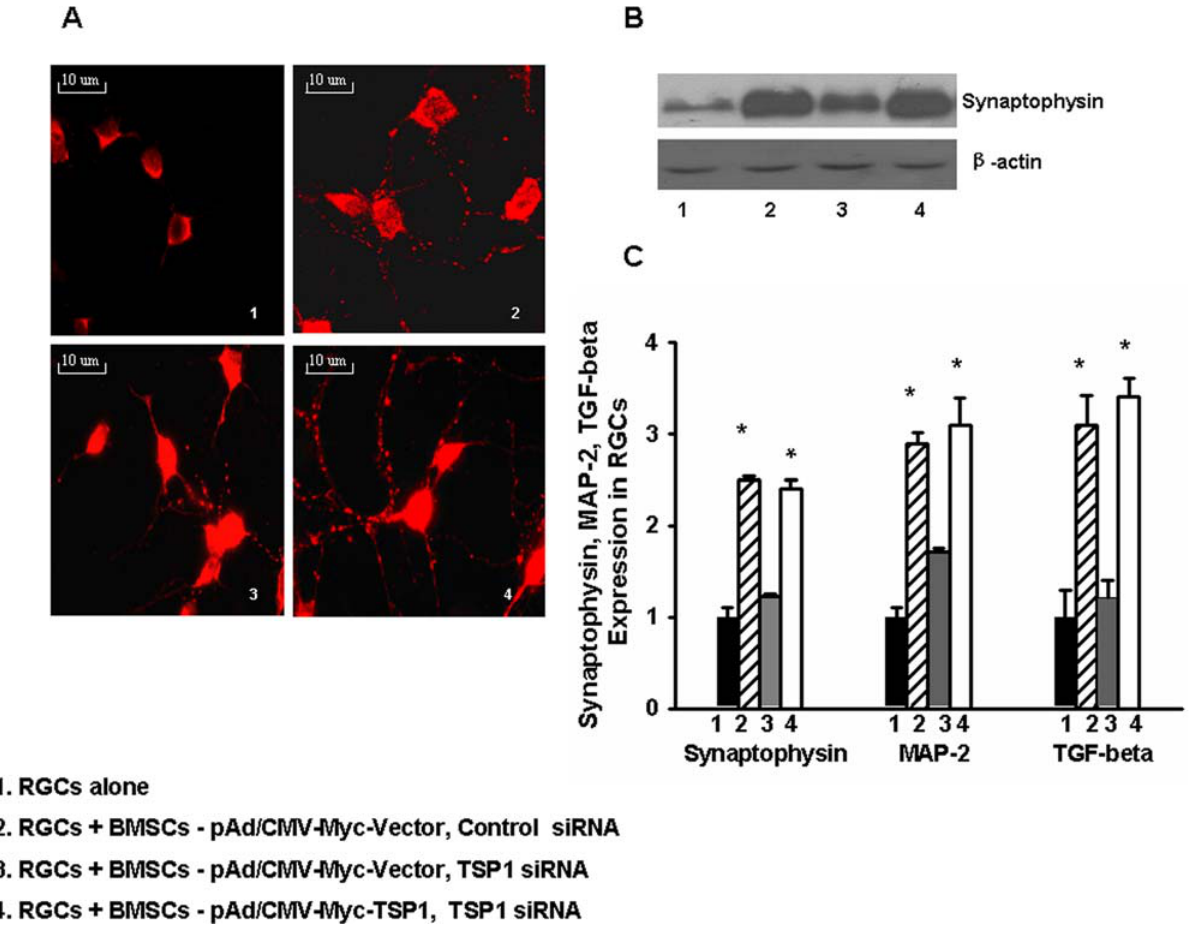
Figure 7. RGC synaptophysin, MAP-2 and TGF- b expression level were determined with and without BMSC ( + / 2 TSP-1 siRNA silencing) co-culturing. BMSCs were transfected with siRNA oligos and infected with a recombinant adenovirus (pAd/CMV-Myc-TSP-1) expressing TSP-1 before co-culturing as described above. A , After 3 days, immunohistochemical analysis of RGCs for synaptophysin (red dots) shows more synaptic puncta when co-culturing with BMSCs compared to RGCs alone (2 & 4), but fewer when TSP-1 was silenced by siRNA (3). B , Western blot shows synaptophysin in RGCs is up-regulated by TSP-1; (2), which was diminished by TSP-1 silencing (3) and restored by TSP-1-expressing adenoviral rescue (4). C , After 3 days, synaptophysin, MAP-2 and TGF- b expression were determined by real-time RT-PCR (p=0.019, p=0.020, p=0.017, respectively). *p-values # 0.05. (The experiments were repeated at least three times).